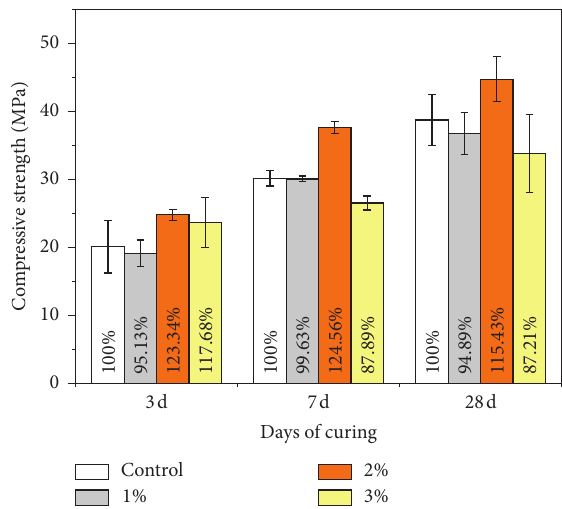
Figure 7: The cement mortar’s compressive strength at different concentrations of calcium acetate.